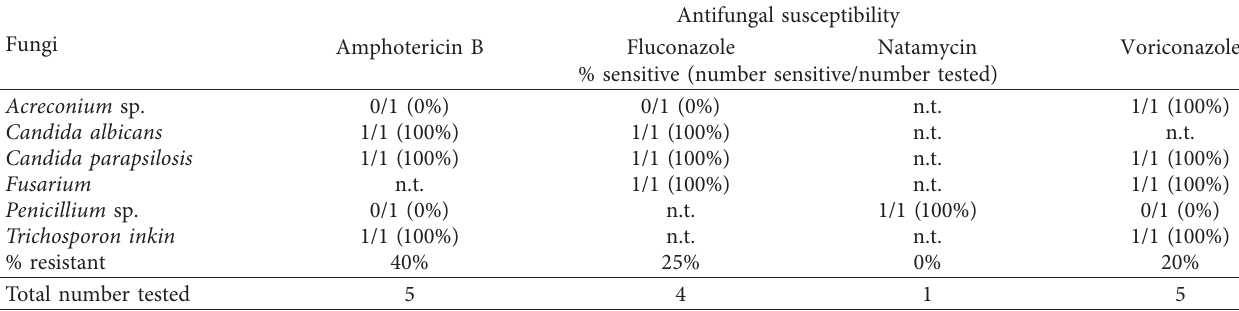
Table 6: Antifungal susceptibility of isolated fungi for patients who underwent enucleation or evisceration due to infectious keratitis between January 2007 and December 2018 at the Department of Ophthalmology of Semmelweis University (Budapest, Hungary) (48 eyes of 47